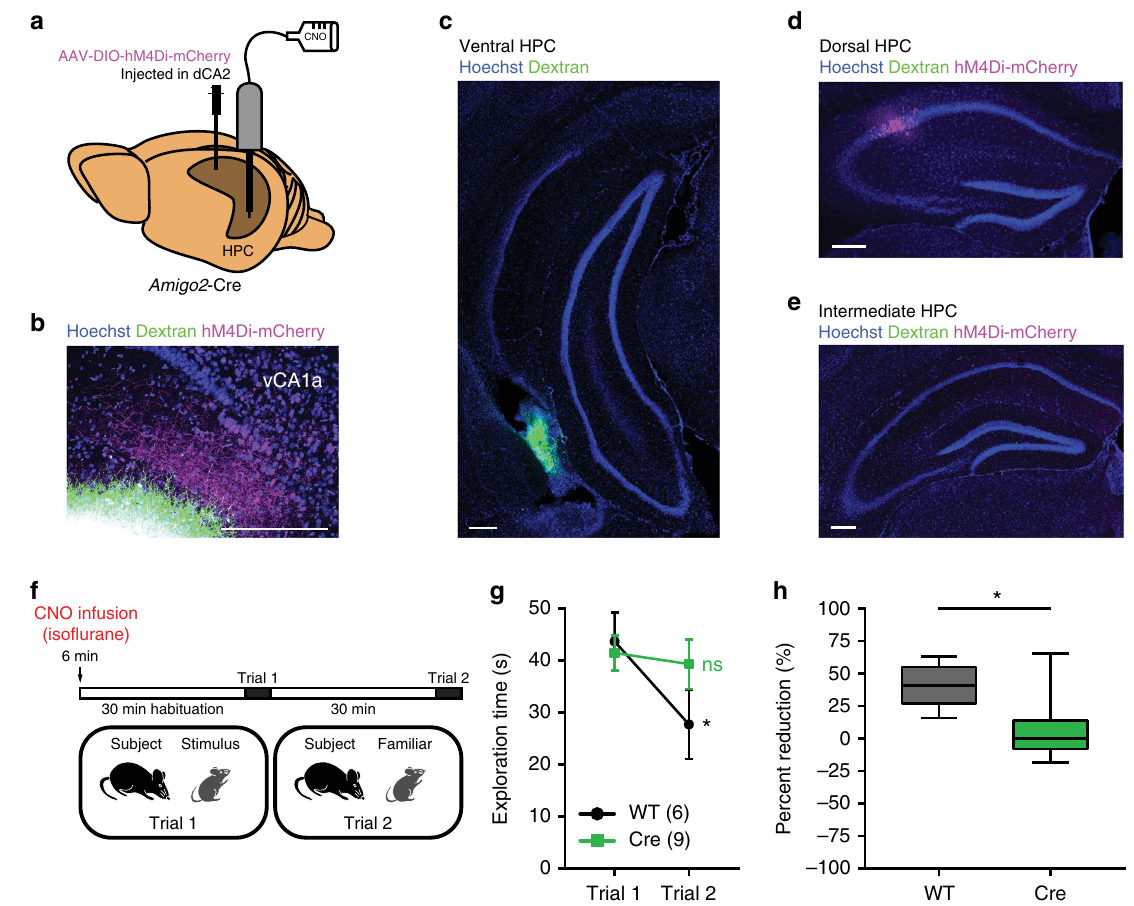
Fig. 8 dCA2 projections to vHPC are necessary for social memory. a AAV-DIO-hM4Di-mCherry was injected in dCA2 of Amigo2 -Cre mice and WT littermates. A cannula guide was implanted for local CNO or dye infusion in vCA1. b Ventral HPC horizontal slice showing overlap between dCA2 fi bers located in vCA1a (labeled with hM4Di-mCherry, magenta) and dextran conjugated to Alexa Fluor 680 (green) infused in vCA1. c Ventral HPC coronal slice from an Amigo2 -Cre mouse after infusion in vHPC of a dextran conjugated to Alexa Fluor 488 (green). d Dorsal HPC coronal slice from same brain as in c , showing expression of hM4Di-mCherry (magenta) but no Alexa signal. e Intermediate HPC coronal slice showing lack of signal for hM4Di-mCherry or Alexa dye. f A direct interaction test was performed 30 min after bilateral local infusion of CNO in vHPC (2 µ L of 1 mM solution per side). g WT mice displayed decreased social exploration time during trial 2 ( n = 6, P = 0.0110, Sidak ’ s multiple comparisons test) whereas hM4Di-mCherry expressing Amigo2 -Cre mice showed no decrease ( n = 9, P = 0.8351, Sidak ’ s multiple comparisons test). The two groups differed signi fi cantly (two-way ANOVA: treatment × trial F (1,13) = 4.964, P = 0.0442). h The percent reduction in interaction time in trial 2 versus trial 1 in Amigo2 -Cre mice was signi fi cantly less than in WT mice (unpaired t test: t (13) = 2.962, P = 0.0110). Results in g show mean ± s.e.m. Box-whiskers plot in h present median (center